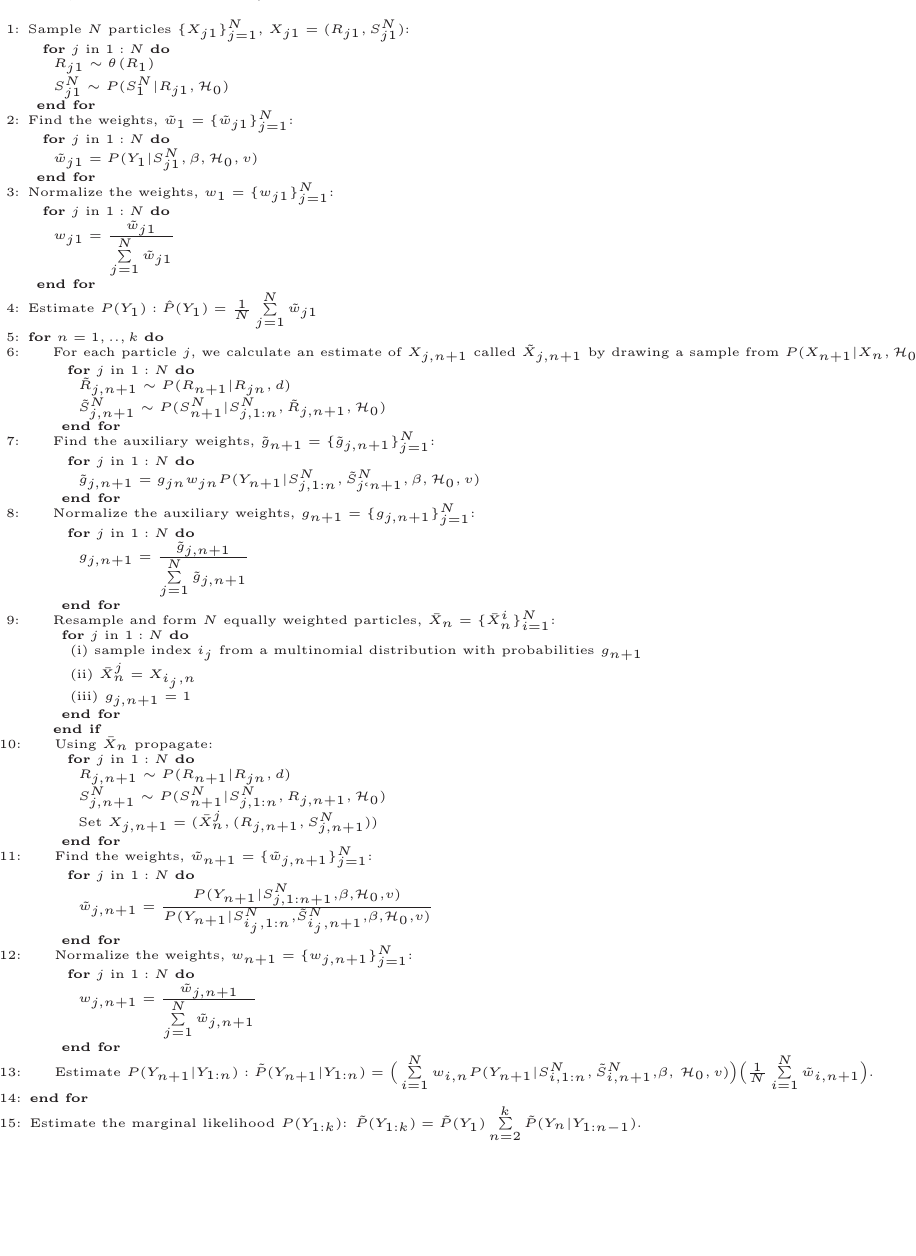
Algorithm 3 Auxiliary particle